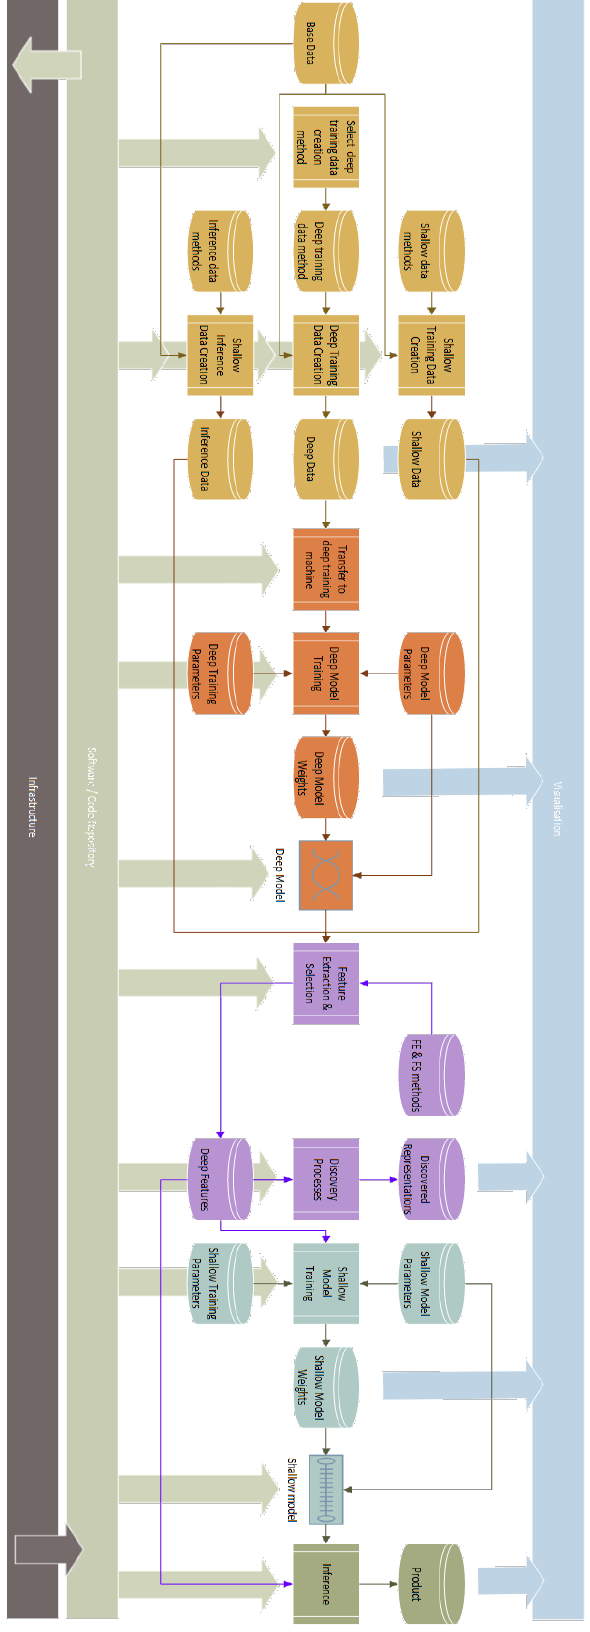
Figure 1. A model of the core components of the TopoNet deep learning method used at Ordnance Survey,